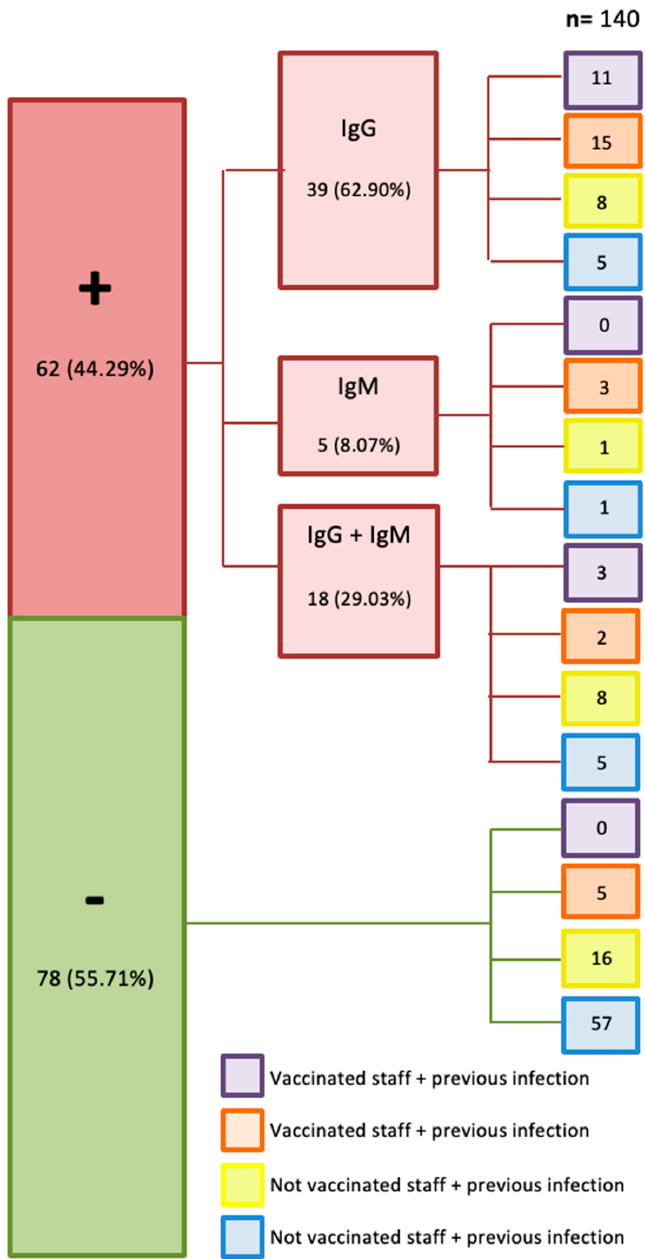
Figure 3. The following representation shows the prevalence of IgM and IgG antibodies for SARS- CoV-2 in the O.S.M. of the cancer center. The big green box represents staff members that do not present antibodies for COVID-19 (55.71%), and the big red box represents staff members that present COVID-19 antibodies (44.29%), which were divided into those that showed antibodies type IgM (8.07%), IgG (62.9%) or both (29.03%). The medical personnel (whether they were positive or negative for COVID-19 antibodies) were in turn divided into personnel who received the vaccine or had a previous infection.